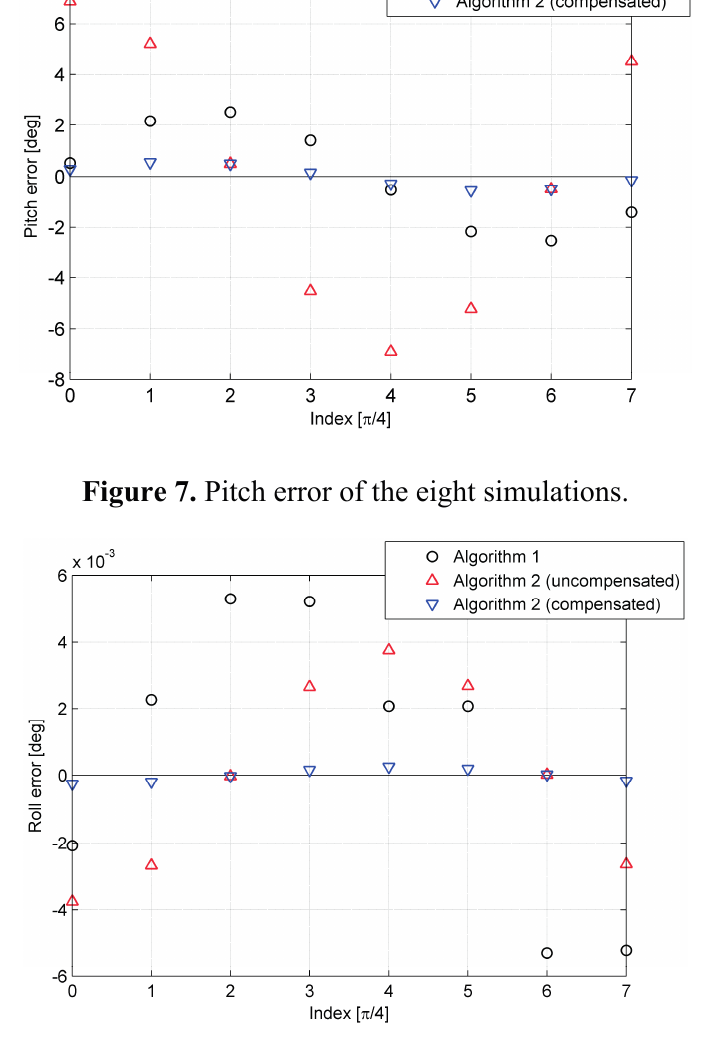
Figure 8. Roll error of the eight